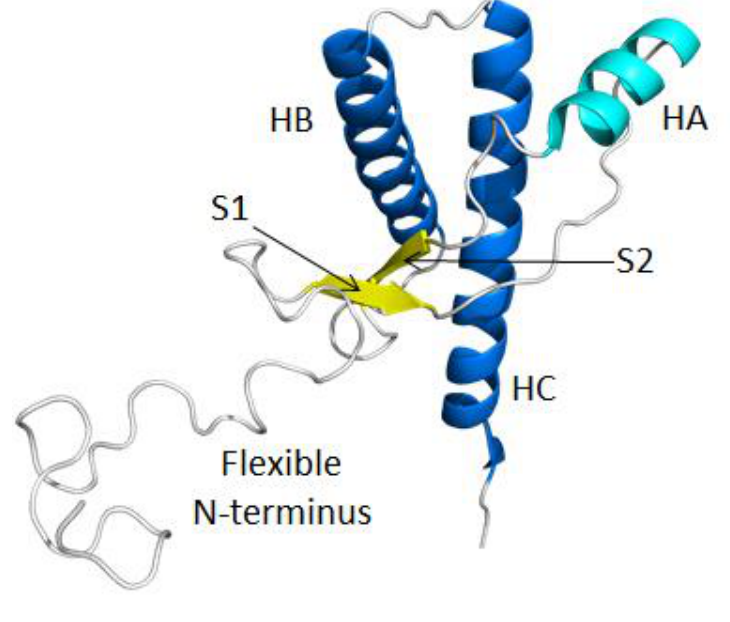
Figure 1. Native structure of bovine PrP C (residues 90–231). HA (Helix A; residues 144–154), HB (residues 173–194) and HC (residues 200–228), S1 (β-strand 1; residues 128–131) and S2 (residues 161–164) are colored in cyan, blue and yellow, respectively. Loop regions are colored in gray. The flexible N-terminal residues 90–127 and C-terminal residues 228–231 were manually constructed. The structure for residues 128–227 was obtained from the bovine PrP NMR structure (Protien Data Bank (PDB) code: 1DWY)